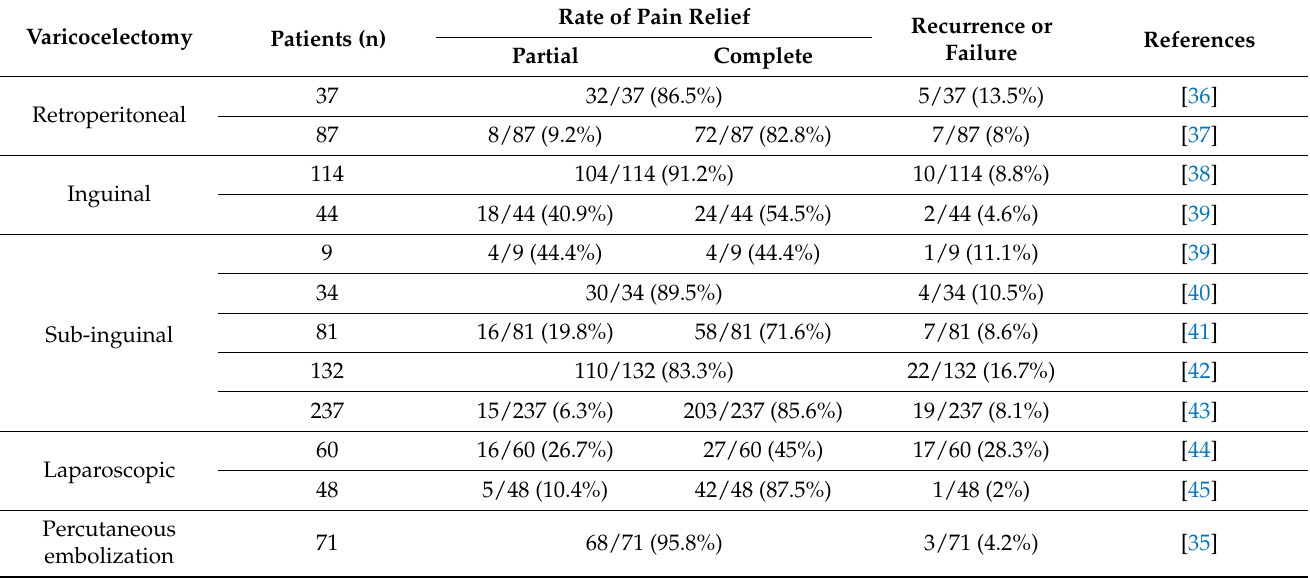
Table 2. Surgical treatments for